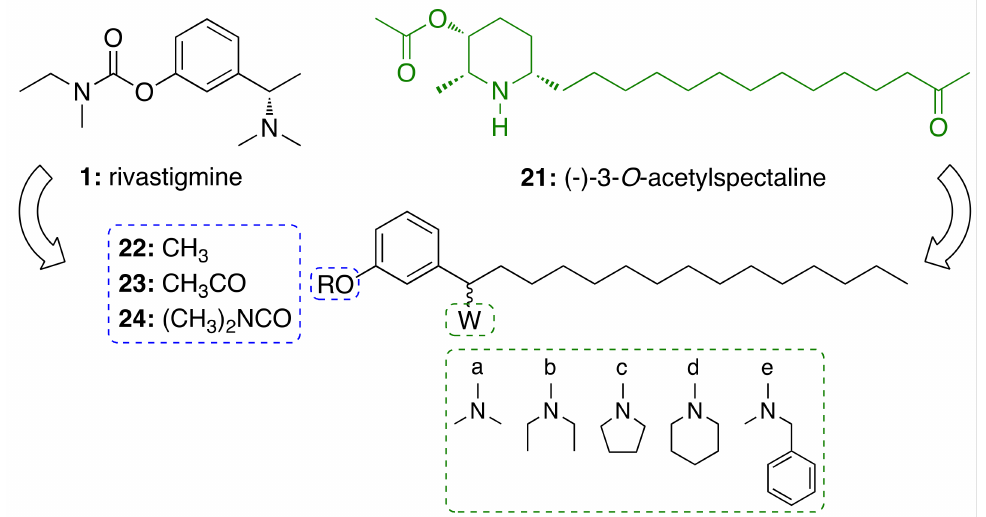
Figure 6. Design of cardanol-derived AChE inhibitors by hybridization between rivastigmine ( 1 ) and ( − )-3-O-acetylspectaline ( 21